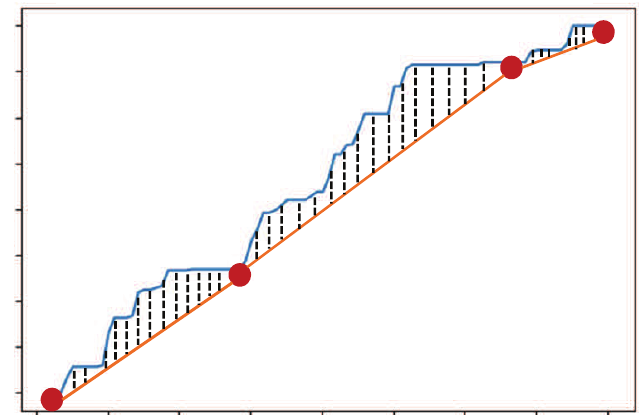
Figure 2. Example of computing the distance between the original health data and the salient data set.